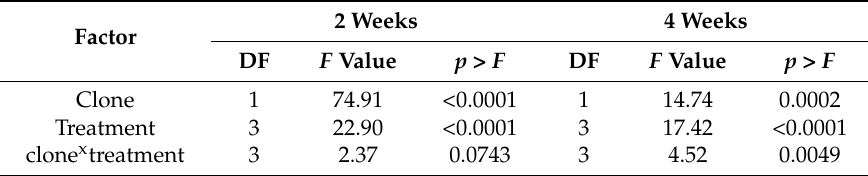
Table 3. The impact of clone and treatment on relative biomass (g mm −1 ) in 2009.